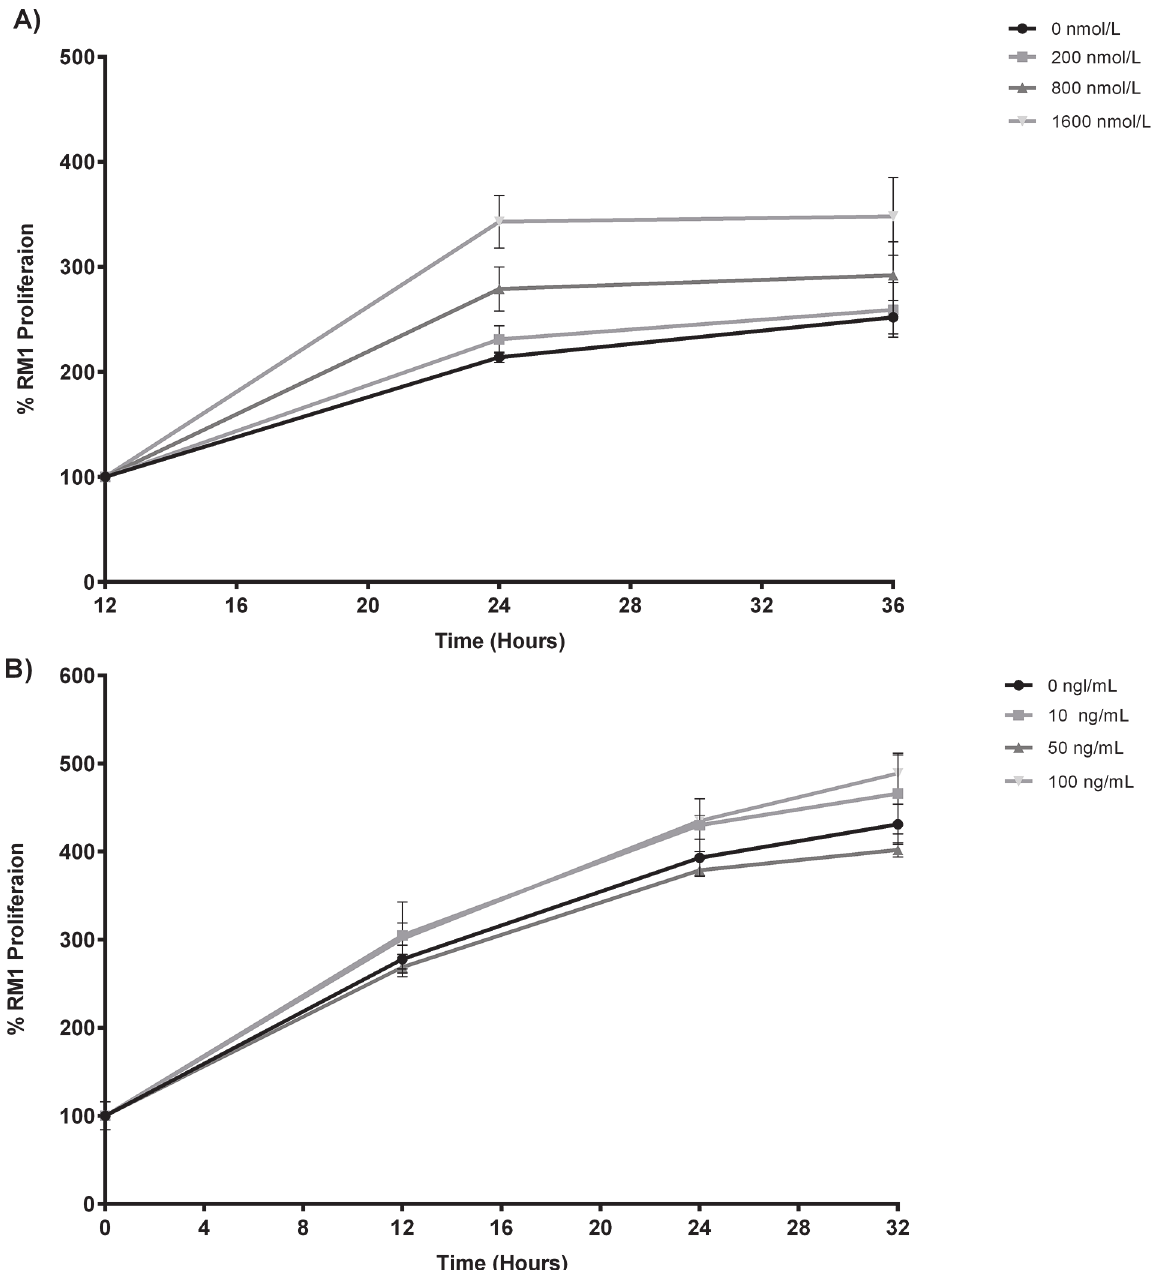
Fig 4. Cell proliferation assay in the presence of insulin e leptin. RM1 cell proliferation in the presence of different insulin concentrations (0, 200, 800, 1600 nmol/L) evaluated by determination of the % of resazurin reduction at different time points (A) (p < 0.01 1600 nmol/L vs 800, 200, 0 nmol/L at 24h, one-way ANOVA, Newman-Keuls multiple comparison post-hoc test). RM1 cell proliferation of in the presence of different leptin concentrations (0, 10, 50, 100 ng/mL) evaluated by determination of the % of resazurin reduction at different time points